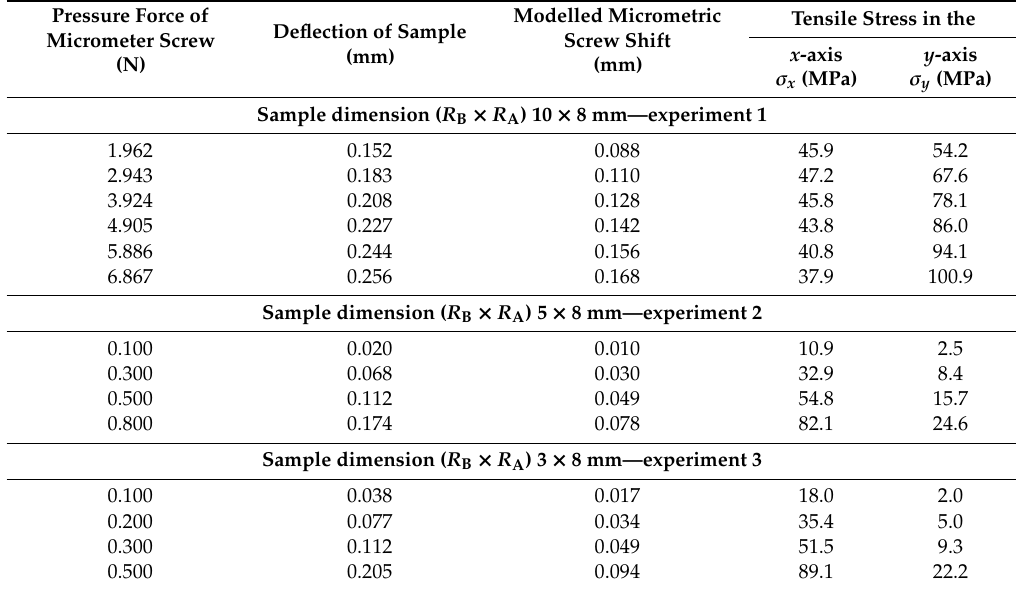
Figure 4. Arrangement of the micrometric screw, ribbon-type sample, and retaining washer for the finite element method (FEM) model. The dimensions are summarized in Table 1. Table 2. Measured values of pressure force of micrometric screw used in the FEM model (Column 1) and parameters obtained from the applied model (Columns 2–5).